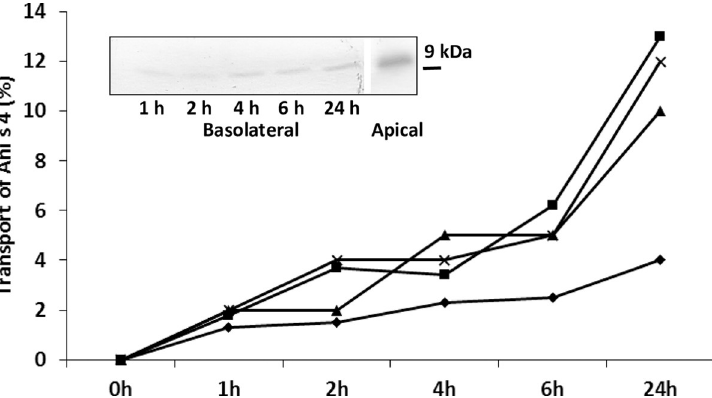
Fig 5. Kinetics of Ani s 4 transfer across Caco-2 monolayer. Caco-2 cells were incubated with 2mg/mL A . simplex CE. Basolateral and apical compartments were analysed for the presence of Ani s 4 at indicated time points. Results are expressed as percentage of total concentration (apical + basolateral compartments) of Ani s 4. Lines denote results from independent experiments. Western blot of a representative case is shown (experiment ▲ ).